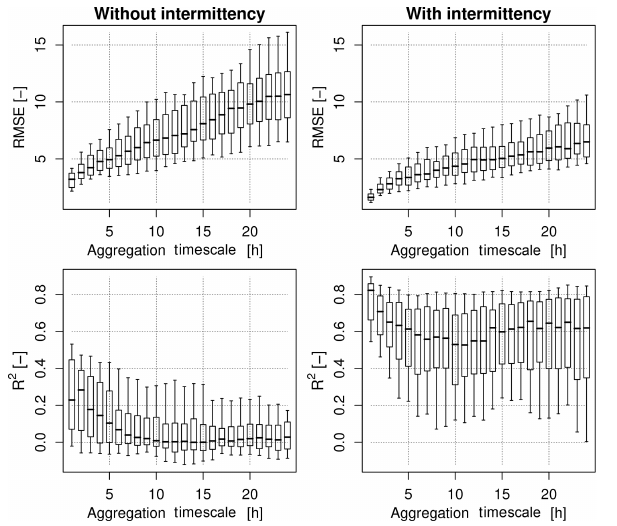
Figure 9. Box plots of root mean square error (RMSE) and coef- ficient of determination ( R 2 ) of the estimated 95th rainfall quantile as a function of scale. The model without intermittency is shown on the left and the model with intermittency on the right. Each box plot shows the 10, 25, 50, 75 and 90% quantiles of all 99 stations in the